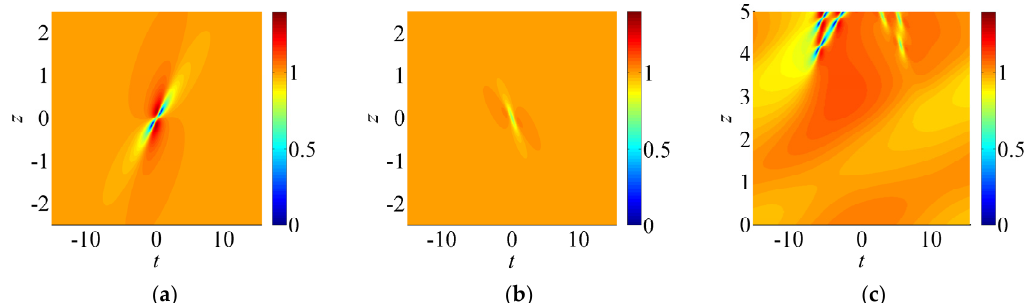
Figure 3. With σ = 10, ρ = 1 and δ = 5, ( a ) the u ‐ component of the first rogue wave mode given by Equations (2) and (3); ( b ) the u ‐ component of the second RW mode; ( c ) the simulated results with the initial condition given by Equation (6) and K = 0.2.